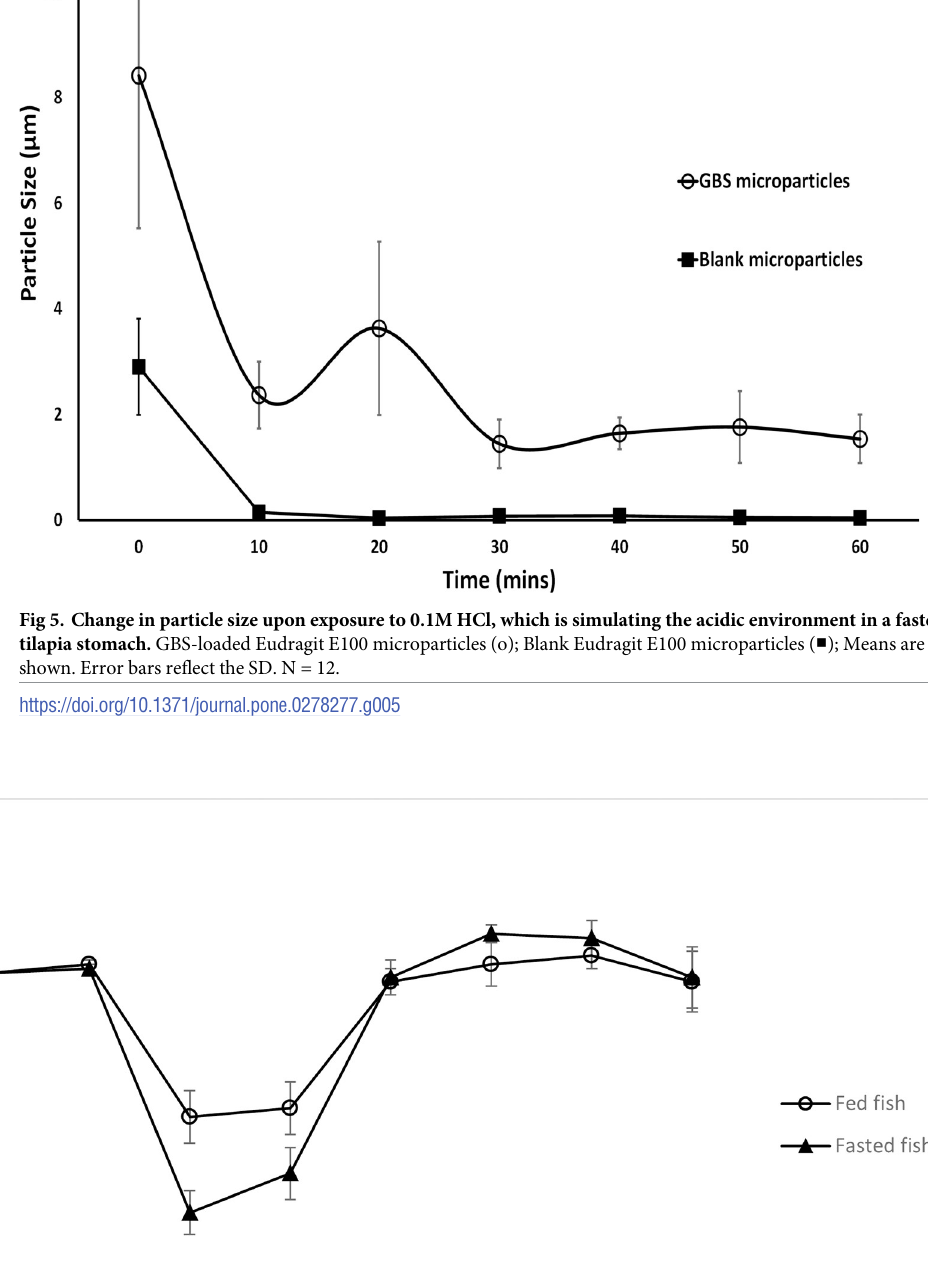
PLOS ONE | https://doi.org/10.1371/journal.pone.0278277 March 3,